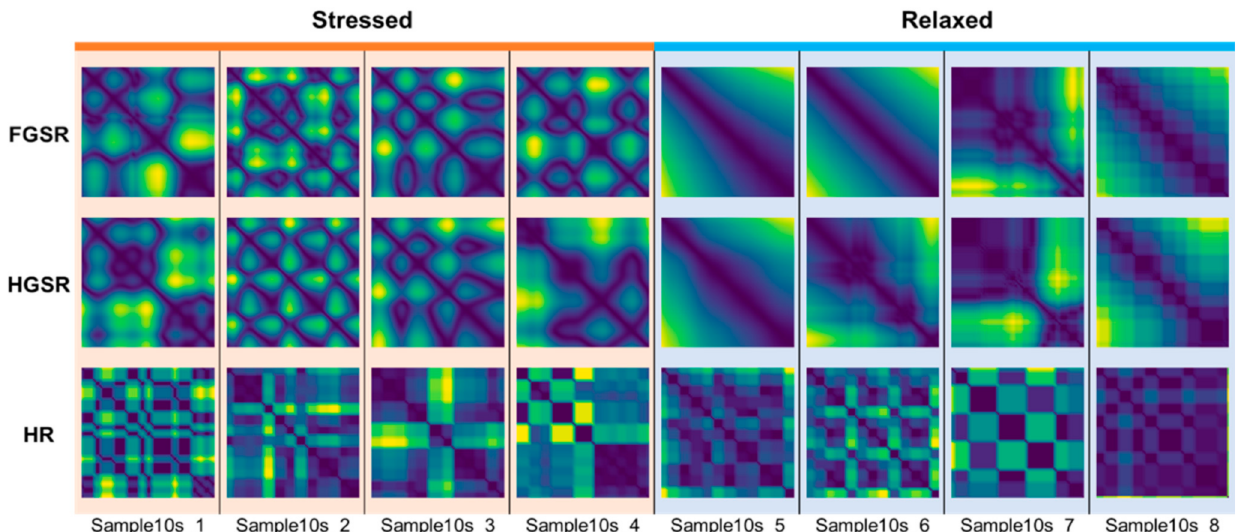
Figure 4. Examples of Cont-RPs for short-term (10 s) FGSR, HGSR, and HR